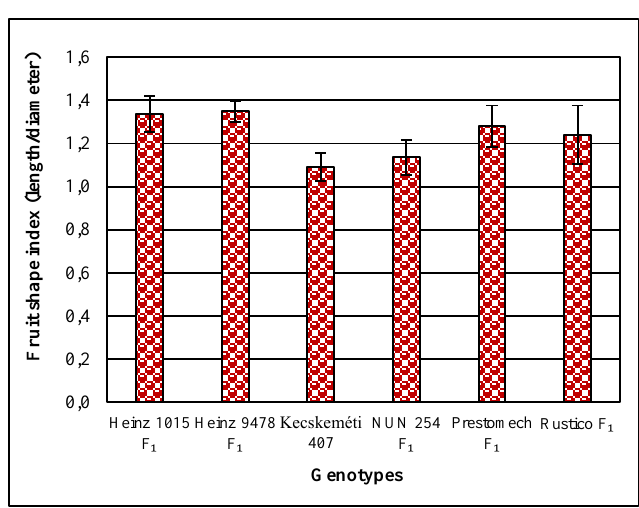
Figure 3. Fruit shape index of different genotypes.